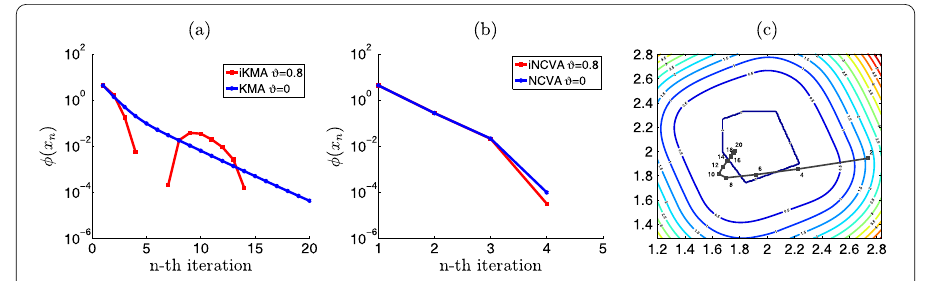
Figure 1 ( a ) Behavior of φ ( x n ) ( n = 1,2, ... ,20) of KMA and iKMA for Example 5.1. ( b ) Behavior of φ ( x n ) ( n = 1,2, ... ,5) of NCVA and iNCVA for Example 5.1. ( c ) The graph of level curve of φ in Example 5.1 with sequence { x 2 k | k = 1,2, ... ,9 } which is generated by